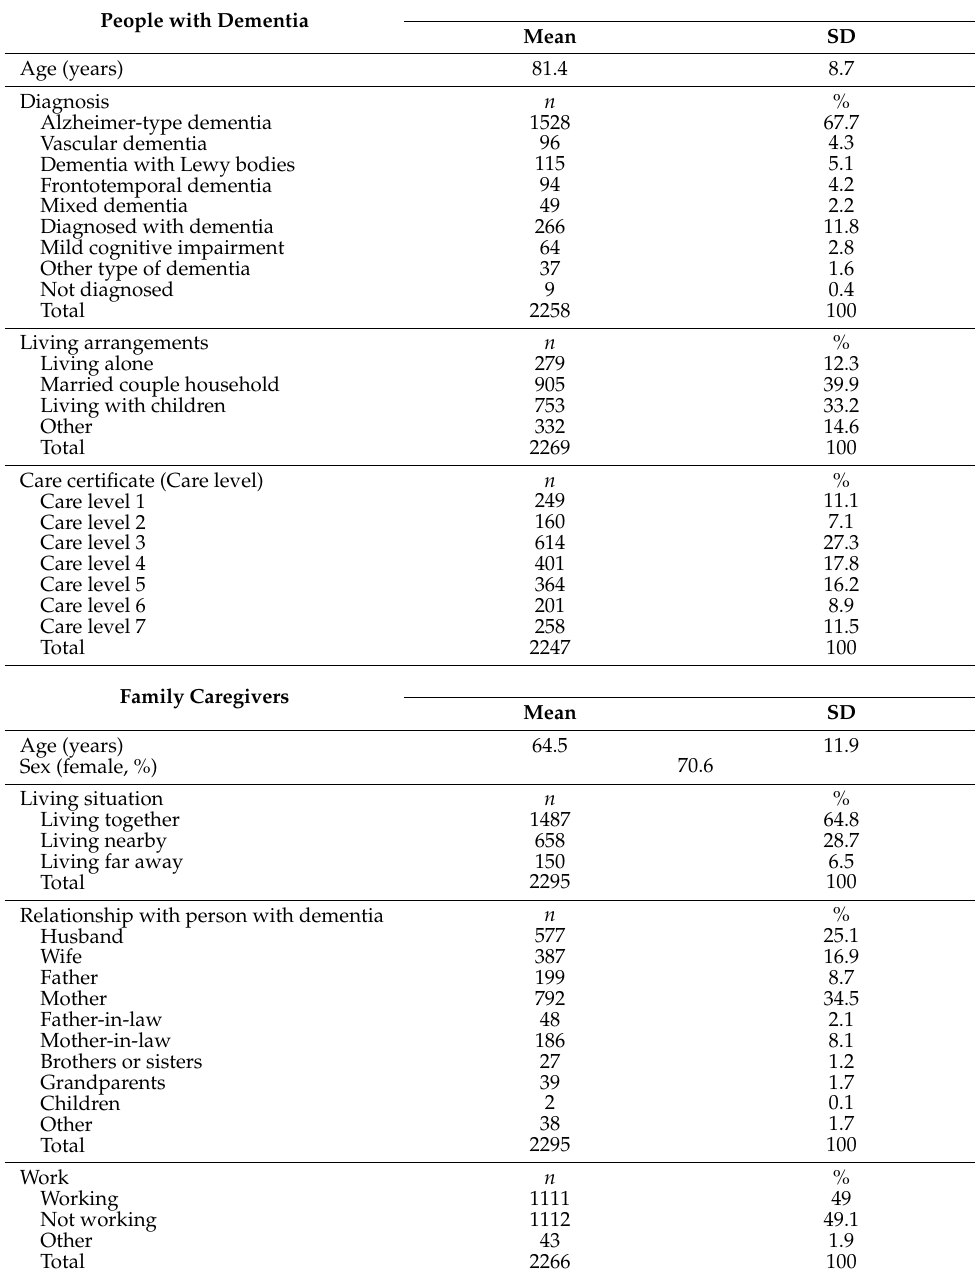
Table 1. Characteristics of the